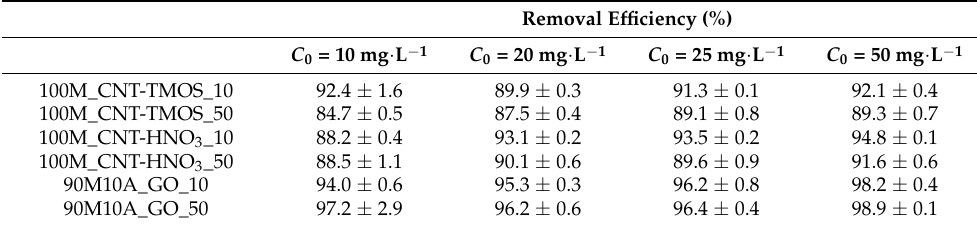
Table 7. Removal efficiency of the carbon nanotubes and graphene oxide–silica aerogel composites with two amounts of carbon nanostructure for different initial concentrations of